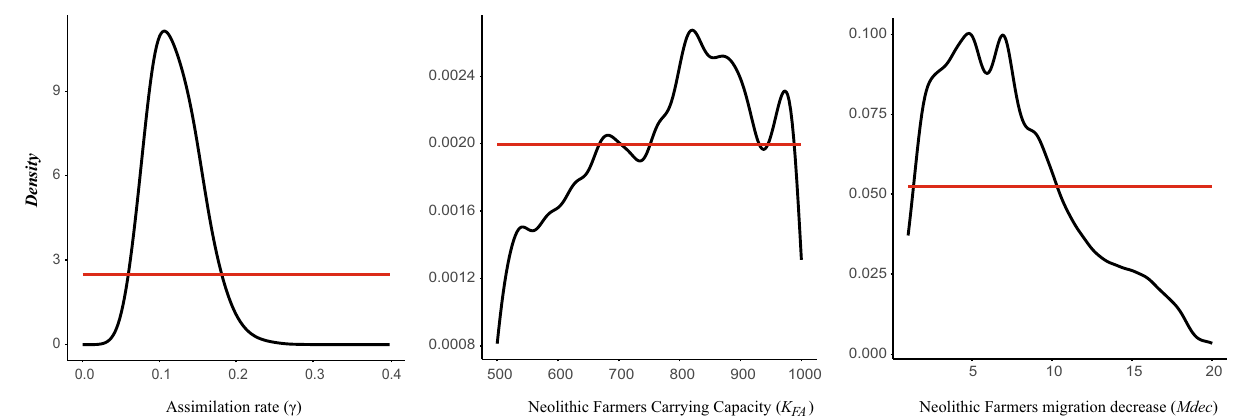
Figure 4. Prior (red line) and posterior (black line) distributions of the parameters estimated for the Neolithic expansion along the Danubian route under Scenario SN2. Τhe assimilation rate (γ) corresponding to the maximum gene flow from hunter-gatherer to the Neolithic farmer population, the carrying capacity of Neolithic farmers (K FA ), the ratio of decrease of migration rate in Neolithic farmers after the colonization phase